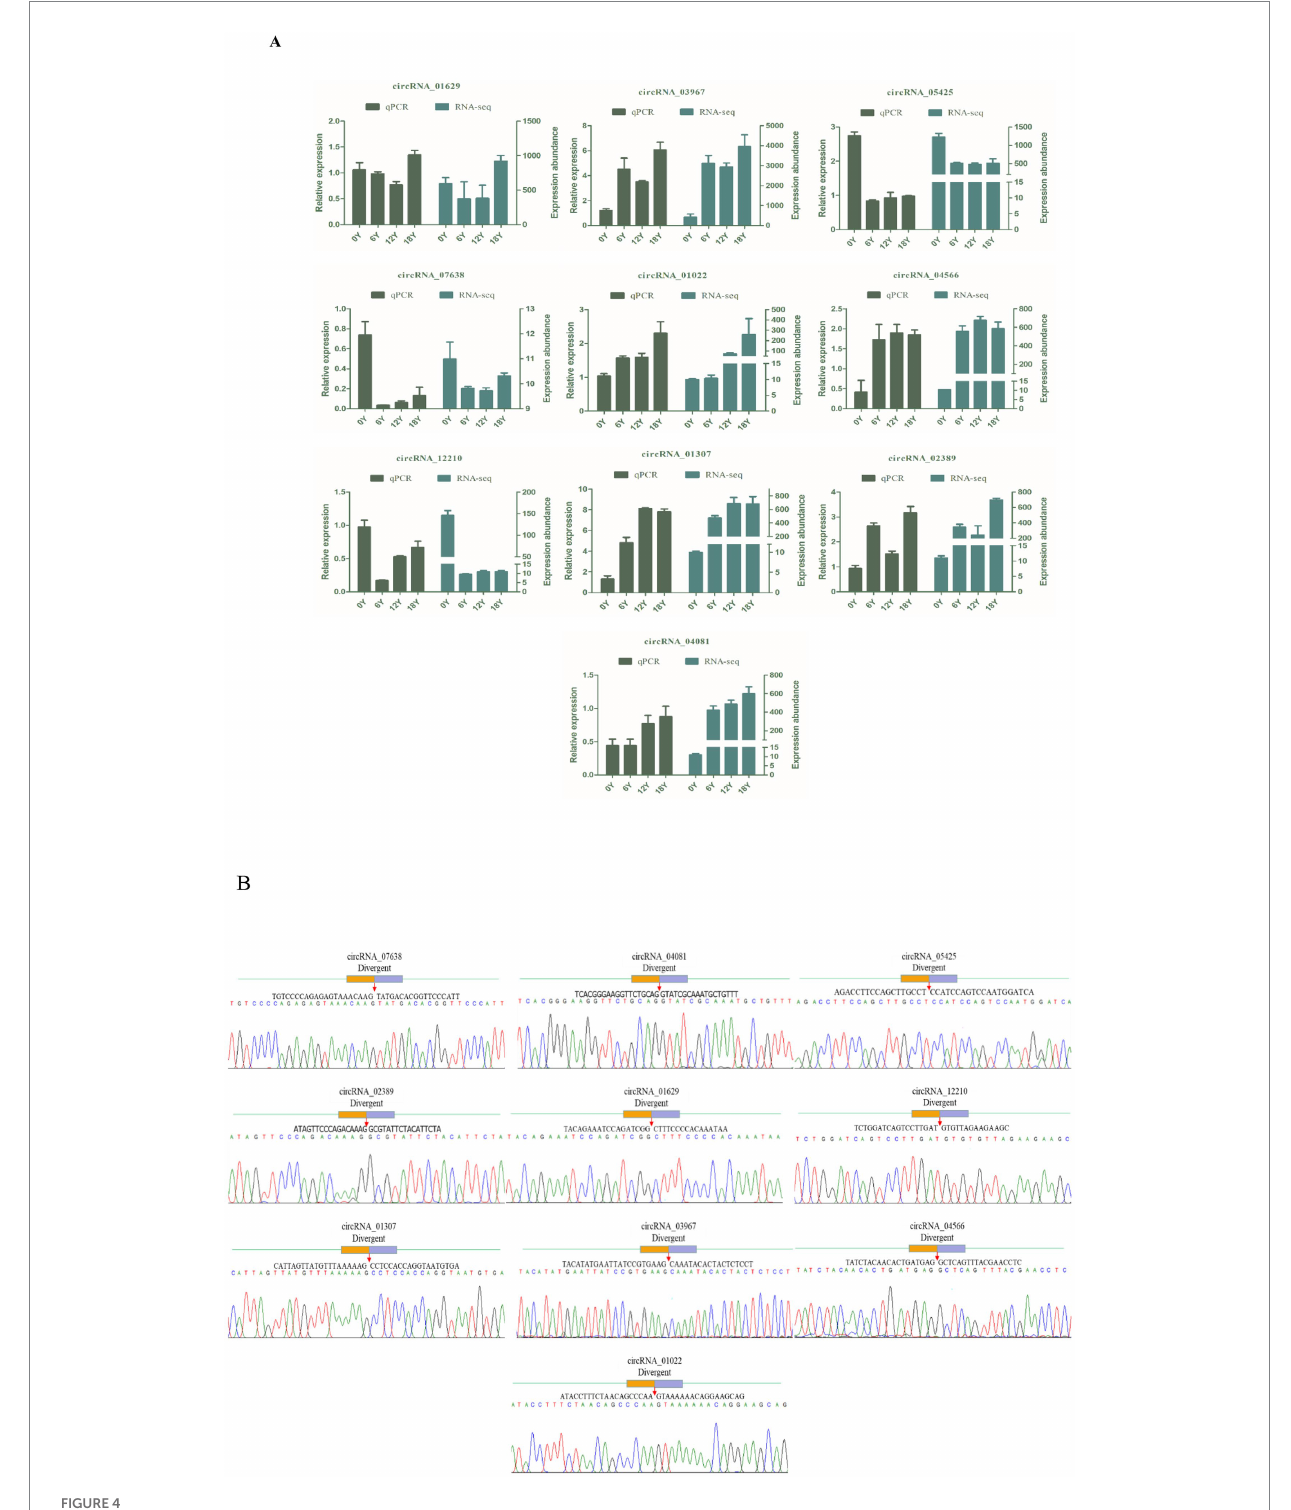
FIGURE 4 circRNA RT–qPCR validation and Sanger sequencing. (A) Comparison of qPCR and RNA-seq results for 10 circRNAs. (B) Circular junctions were confirmed by Sanger